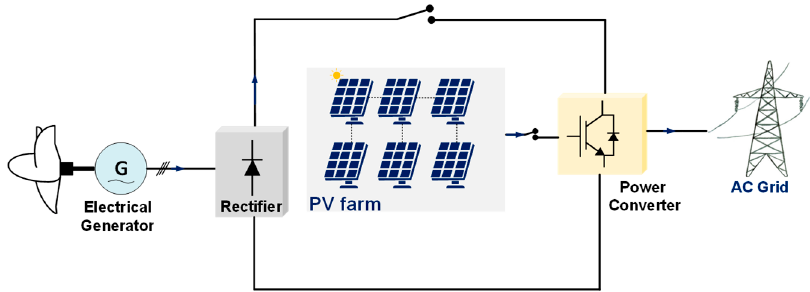
Figure 5. Power transfer from RESs to AC grid.